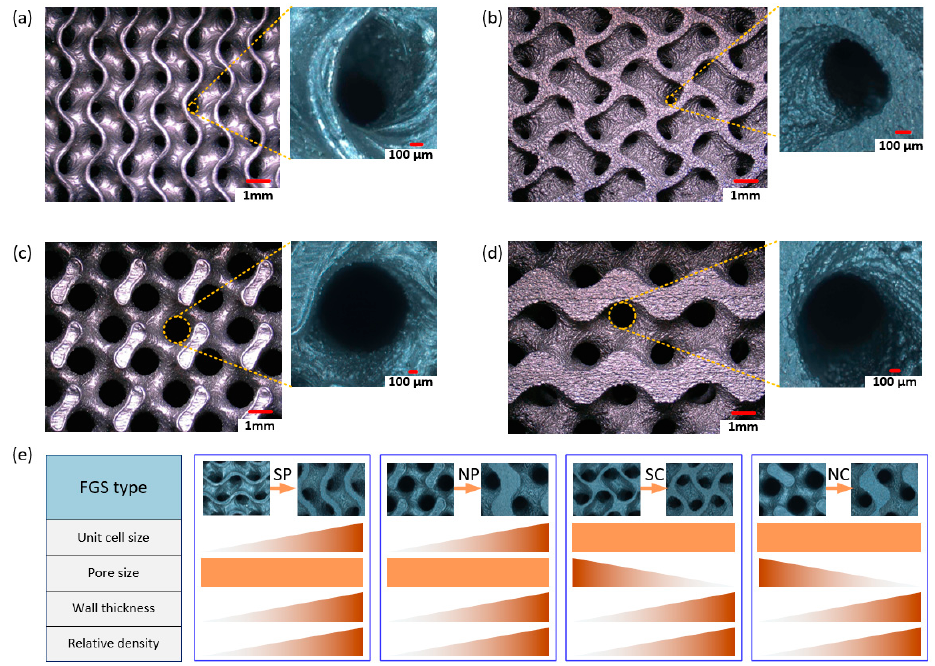
Figure 4. Microstructural analysis of different types of FGS: ( a ) top surface of SP, ( b ) bottom surface of SP, ( c ) top surface of NP, ( d ) bottom surface of NP, and ( e ) changes in related parameters with grading relative density.